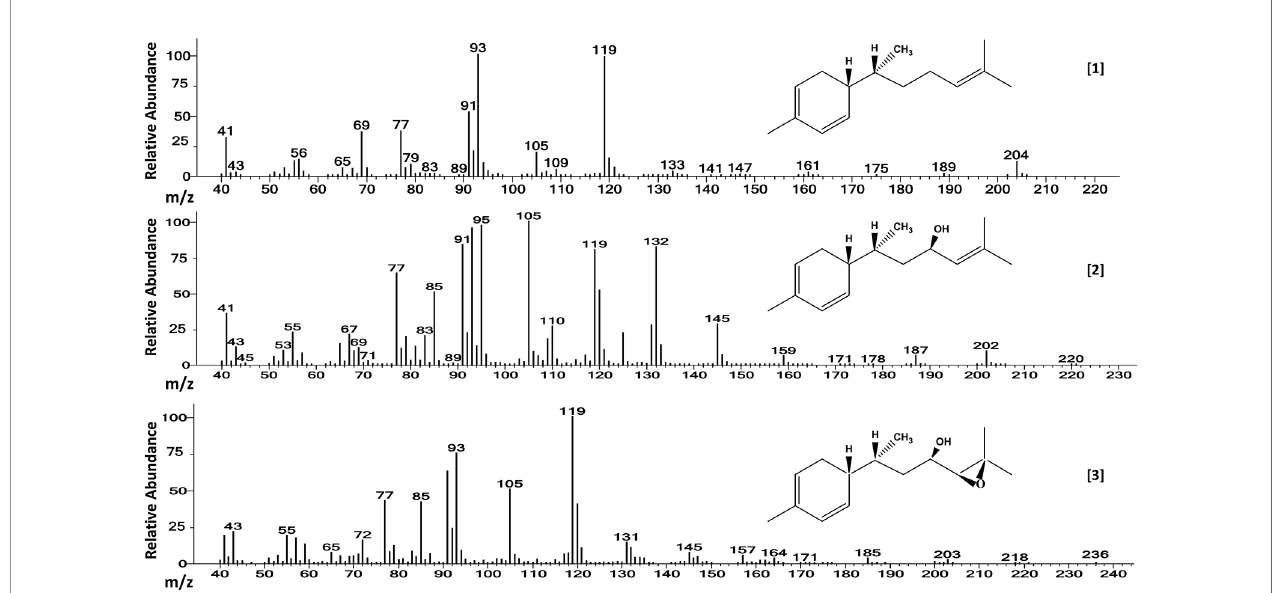
FIGURE 3 | Electron ionization mass spectra of [1] 7-epi-zingiberene (C15H24), [2] 9-hydroxy-zingiberene (C15H24OH), and of [3] 9-hydroxy-10-11-epoxy- zingiberene (C15H24O2), present in trichome secretions of S. habrochaites accessions LA2329-A, LA2167, and PI127826. The names of three major components were obtained by comparing our results from GC-MS with those results published by Anonymous (2017) which was based on the analysis of trichome secretion components present on